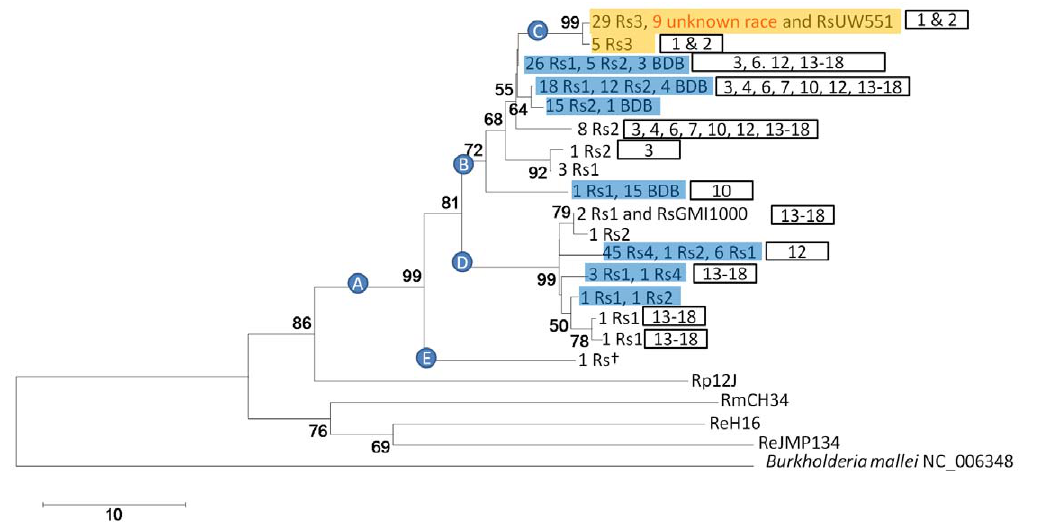
Figure 4. Ralstoniasolanacearum strains classified based on RIF genotypes. The rooted neighbor-joining cladogram was constructed from 210 characterized Ralstonia strains from the PBC (Table 2), six reference strains from GenBank (see Table 1 for strain names)and the outgroup Burkholderia mallei . Identical sequences are represented only once and the number of sequenced strains is indicated on each leaf. Bootstrap values . 50% (shown at the node) are expressed as a percentage of 5,000 replicates. All Rs strains (clade A) are clearly separated from other Ralstonia species. Rs1, Rs2, Rs3 and Rs4 are the four races of R. solanacearum , BDB is the blood disease bacterium and Rs { is R. solanacearum UW433 (ACH0732) which is an atypical race 1 biovar 2 strain [19]. Blue boxes contain strains of Rs races 1, 2, 4 and BDB that share an identical RIF sequence. In contrast, orange boxes contain only Rs3 strains showing that these RIF sequences are specific to race 3. Numbers in boxes next to tree leaves are egl sequevars obtained for those strains. Red text indicates Rs strains with no previous race designation.